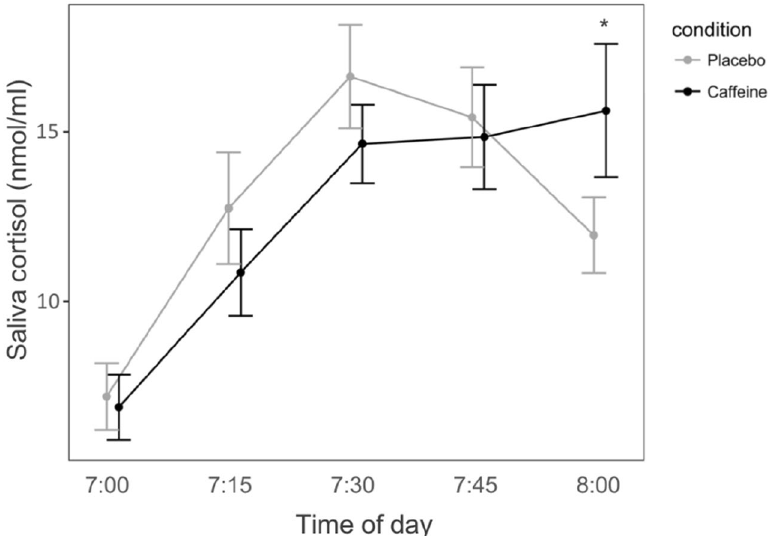
Figure 5. Salivary cortisol awakening response (CAR). Mean salivary cortisol concentration (dots) and standard error of the mean (vertical lines) are shown. Grey lines indicate the placebo condition; black lines indicate the caffeine condition. * p < 0.05 (Benjamini–Hochberg corrected).